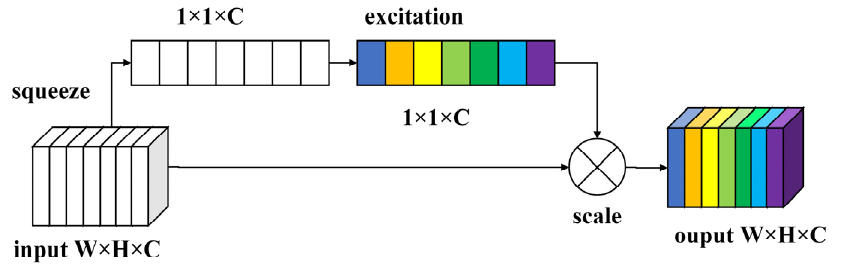
Figure 6. Structure of squeeze and excitation module.